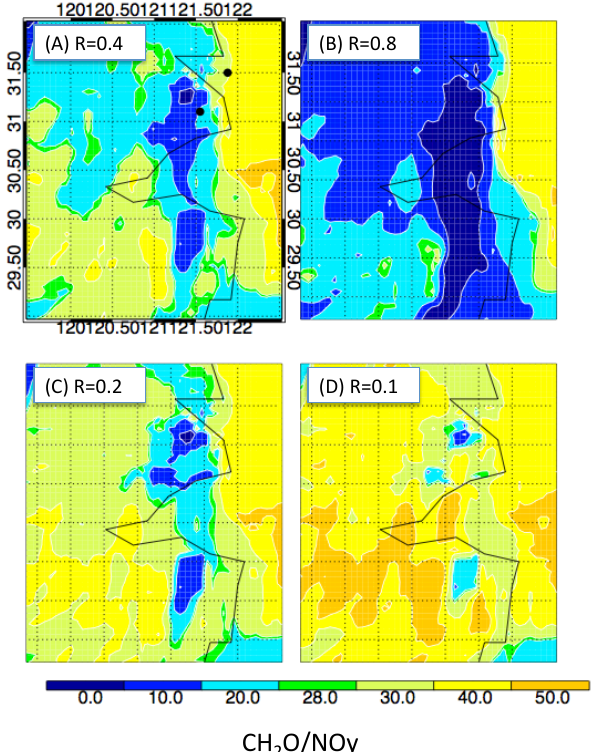
Fig. 13. The calculated ratio of CH 2 O/NO y on 12 September in the Shanghai region, with different emission ratios of NO x /VOCs in the model. The 4 panels represent different emission ratios, such as (A) with the ratio of 0.4, (B) with the ratio of 0.8, (C) with the ratio of 0.2, and (D) with the ratio of